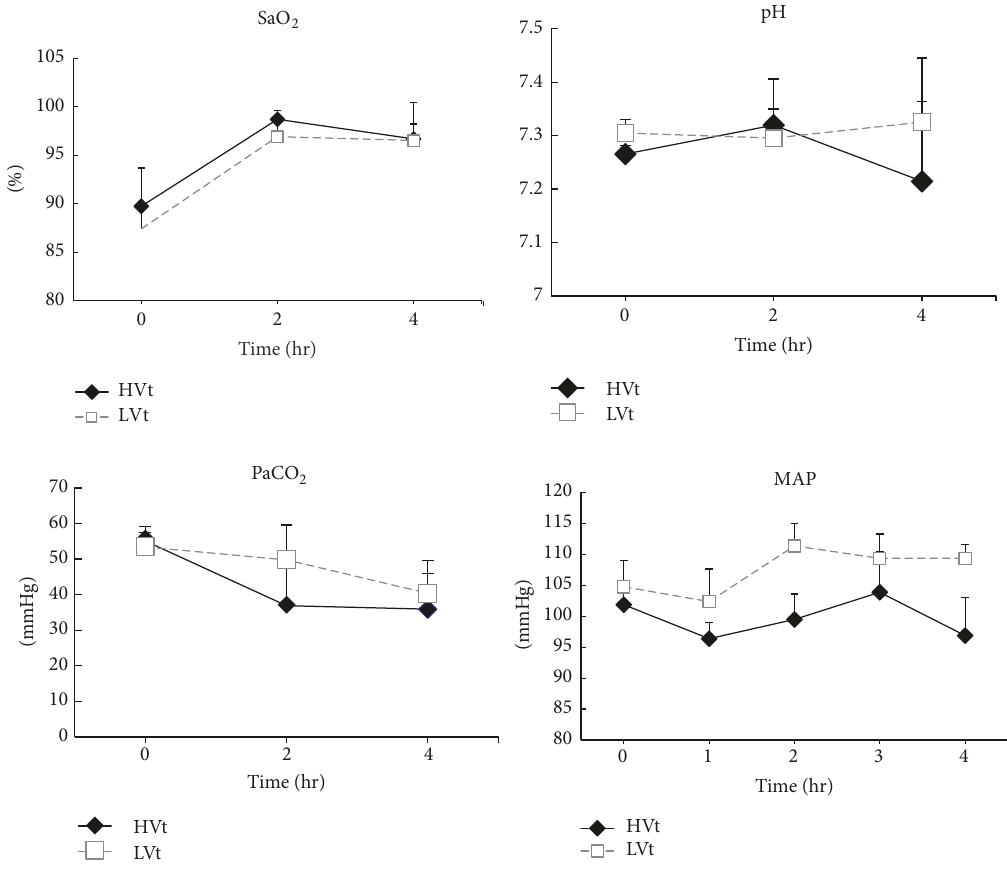
Figure 1: Hemodynamic and respiratory characteristics of rats during the four-hour period of ventilation . No differences between groups were observed at baseline. MAP remained stable in both groups. There were no differences between the LVt and HVt for arterial oxygen saturation (SaO 2 ). PaCO 2 in LVt animals was higher than in HVt animals. The pH decreased slightly in the HVt animals at four hours. But neither PaCO 2 nor pH had significant difference between two ventilatory groups during 4-hour period. Data are presented as the mean ± SD. 𝑁 = 8 animals per group. MAP, mean arterial pressure; BAS, basal; LVt, low tidal volume; HVt, high tidal volume; SaO 2 , arterial oxygen saturation; PaCO 2 , partial pressure of carbon dioxide in arterial